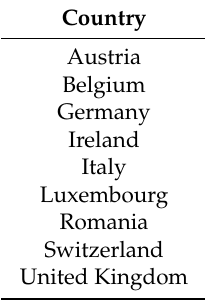
Table A3. Information about people who contributed to the interactive